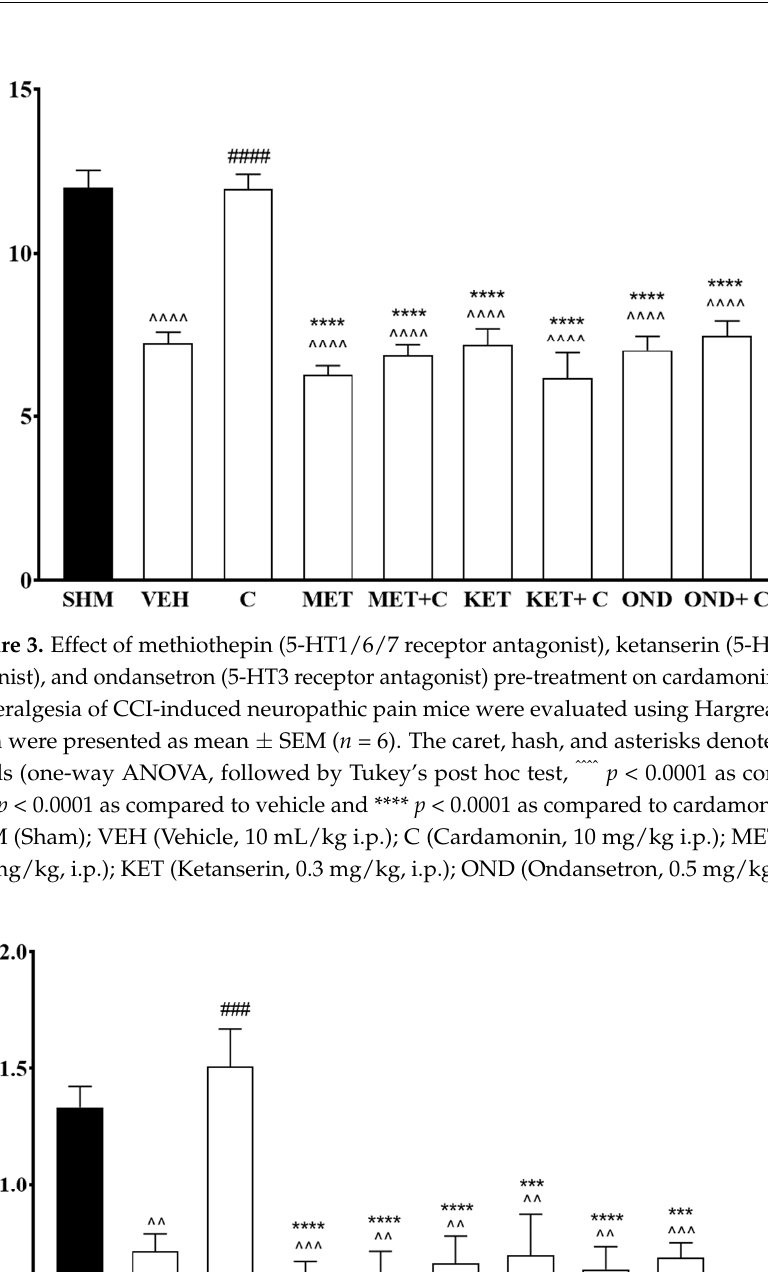
Figure 4. Effect of methiothepin (5-HT1/6/7 receptor antagonist), ketanserin (5-HT2A receptor antagonist), and ondansetron (5-HT3 receptor antagonist) pre-treatment on cardamonin against mechanical allodynia of CCI-induced neuropathic pain mice were evaluated using von-Frey filament test. Data were presented as mean ± SEM ( n = 6). The caret, hash, and asterisks denote the significance levels (one-way ANOVA, followed by Tukey’s post hoc test, ˆˆ p < 0.01, ˆˆˆ p < 0.001 as compared to sham, ### p < 0.001 as compared to vehicle and *** p < 0.001, **** p < 0.001 as compared to cardamonin-treated group. SHM (Sham); VEH (Vehicle, 10 mL/kg i.p.); C (Cardamonin, 10 mg/kg i.p.); MET (Methiothepin, 0.1 mg/kg, i.p.); KET (Ketanserin, 0.3 mg/kg, i.p.); OND (Ondansetron, 0.5 mg/kg,